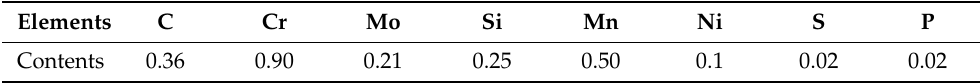
Table 1. The chemical compositions of 35CrMo steel in this study.